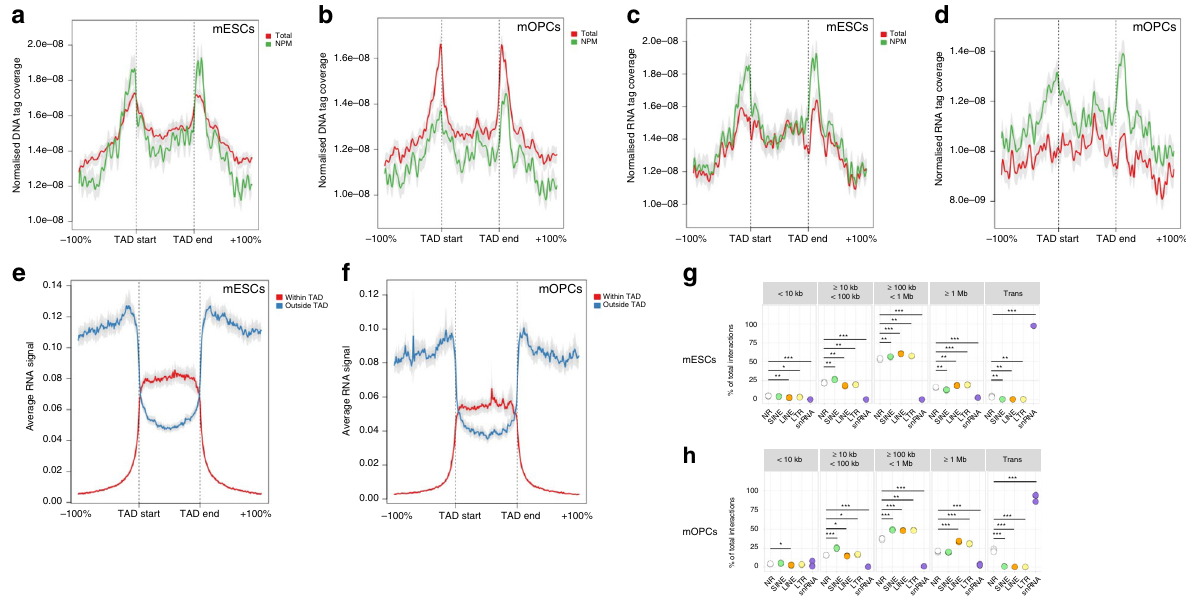
Fig. 4 RNA interactions and genomic structural features. a – d Metadata pro fi les showing the average coverage of a , b DNA tags or c , d RNA tags at the boundaries of TADs in mESCs ( a , c ) and mOPCs ( b , d ) for the indicated conditions. e , f Average RNA-binding signal at TAD boundaries in total mESCs and mOPCs, respectively. The signal was split based on whether the RNA originated within or outside of the TAD. Coverage distance from the TAD is relative to the corresponding TAD width. g , h Percentage of RNA – DNA interactions in total RADICL-seq libraries from mESCs and mOPCs, respectively, divided into incremental RNA – DNA distances and with RNA tags grouped by the identity of intersected repeat elements. NR, RNA tags not mapped on any repeat. Statistical signi fi cance was calculated with the two-tailed Student ’ s t test. * P ≤ 0.05; ** P ≤ 0.01; *** P ≤ 0.001. All panels were generated using signi fi cant datasets. Source data are available in the Source Data File.